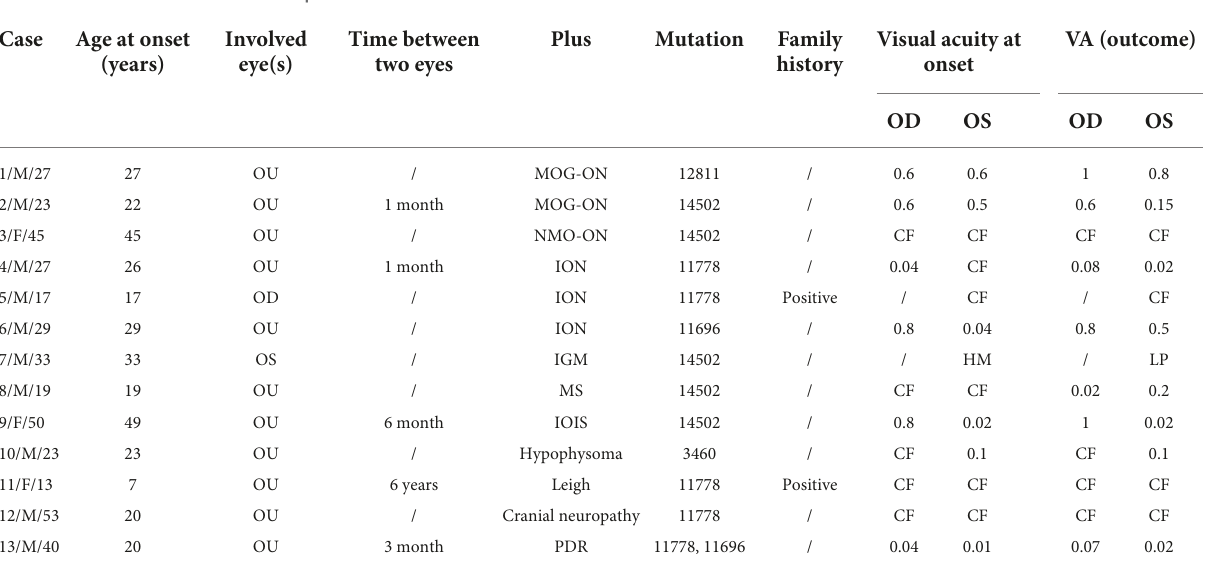
TABLE 1 Clinical features data for 13